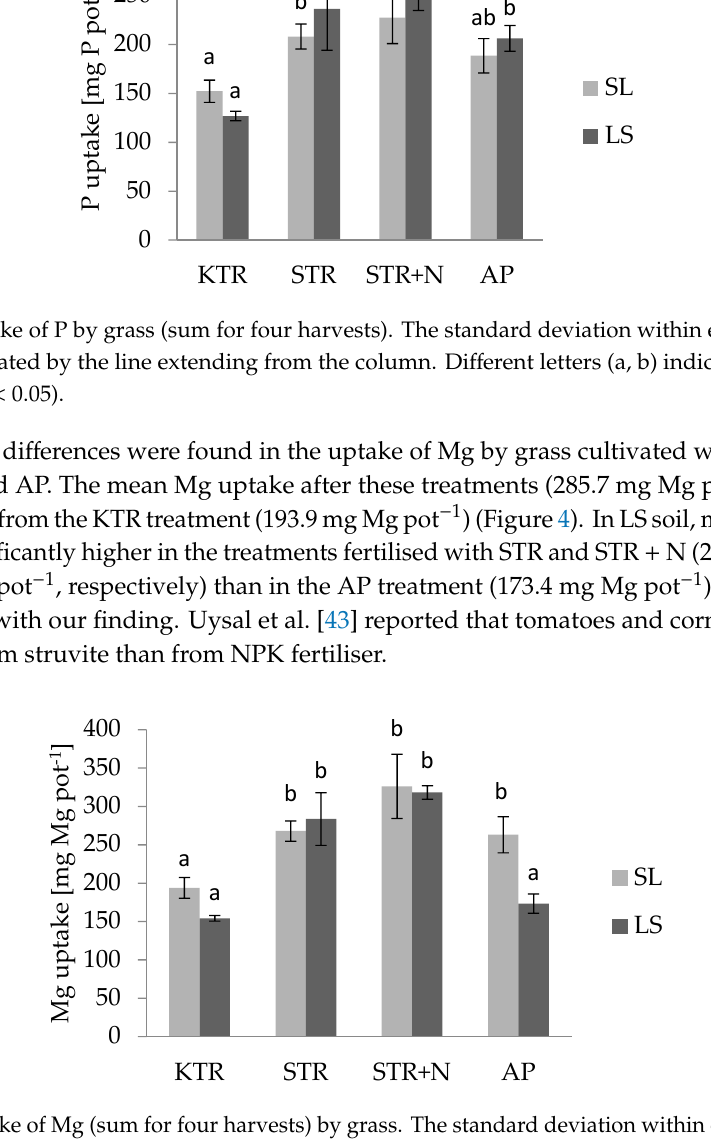
Figure 4. Uptake of Mg (sum for four harvests) by grass. The standard deviation within each treatment (n = 3) is indicated by the line extending from the column. Different letters (a, b) indicate significant differences ( p < 0.05).